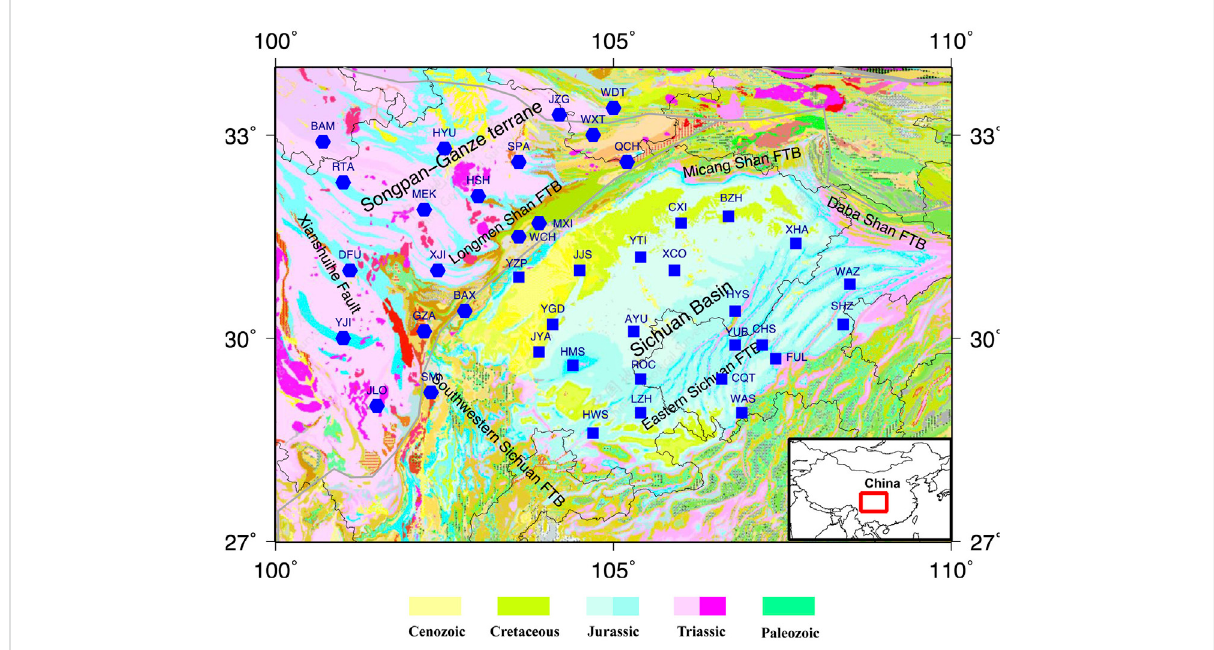
FIGURE 1 Geologic map of the Sichuan Basin and the Songpan-Ganze terrane, including the surrounding structural belts, Longmen Shan fold and thrust belt(FTB), Micang ShanFTB, Daba Shan FTB,Eastern Sichuan FTB andSouthwesternSichuanFTB. Locations ofbroadbandstationsused inthisstudy areplottedassquares(intheSichuanBasin)andhexagons(intheSongpan-Ganzeterrane).Thethickrectangleintheinsetmapshowsthelocationof the study region. Geologic map is adapted from the 1:500,000 digital geological map of China, China Geological Survey (CGS,